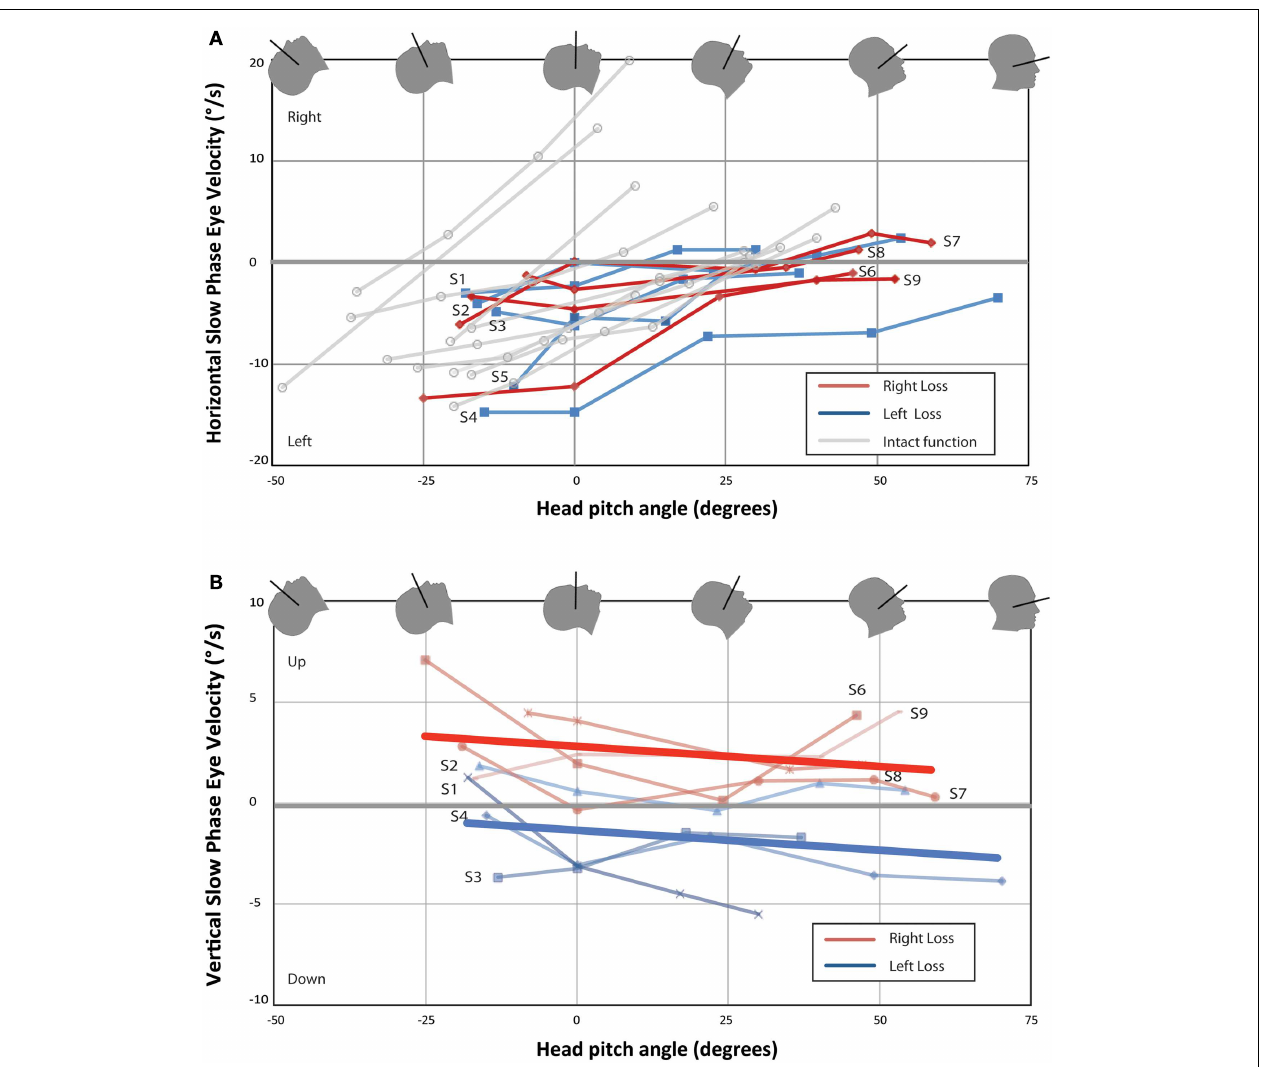
Lines of best-fit (linear least-squares method) are shown in (B) for right-sided UVH and left-sided UVH. (A) All subjects developed a slow-phase left nystagmus that decreased in velocity with chin down head pitch, with four subjects demonstrating reversal of horizontal nystagmus direction with head pitch beyond a null position. (B) Right-sided loss subjects developed slow-phase-up nystagmus inside the magnetic field and left-sided loss subjects developed slow-phase-down